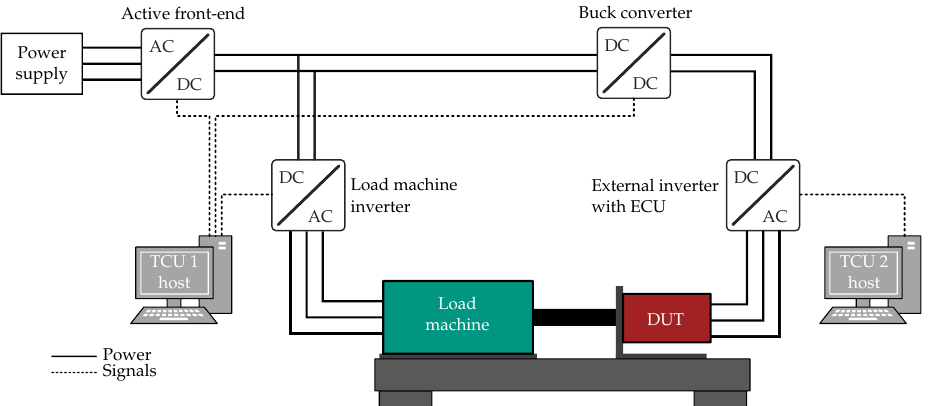
Figure 2. Schematic setup of the EM test